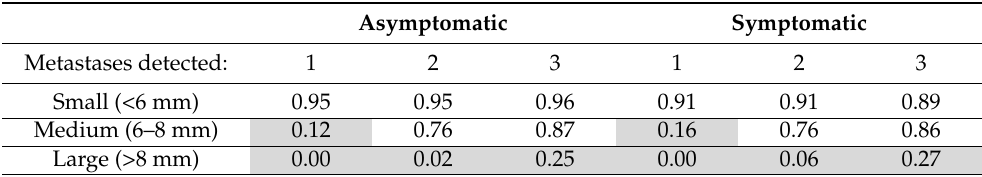
Table A2. Proportion of oligo+ within patients with detected oligo-metastases in the M total Upper scenario. Asymptomatic Symptomatic